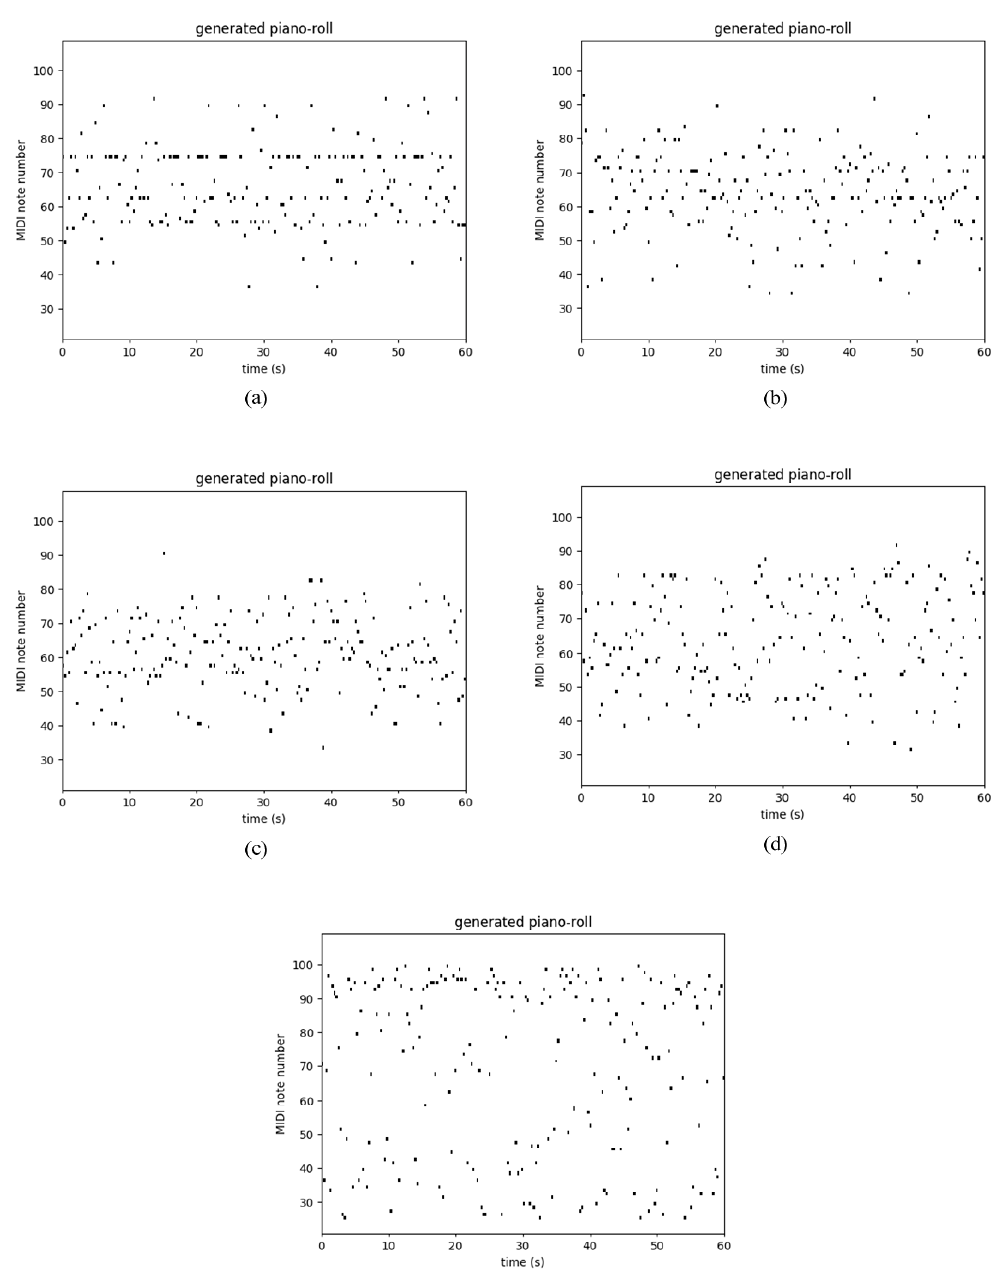
Figure 9. Sample of polyphonic music generation by the ( a ) RNN [9], ( b ) LSTM [16] and ( c ) GRU [17], ( d ) Res-RNN and ( e ) Res-RNN with gates trained with the databases of Piano-midi.